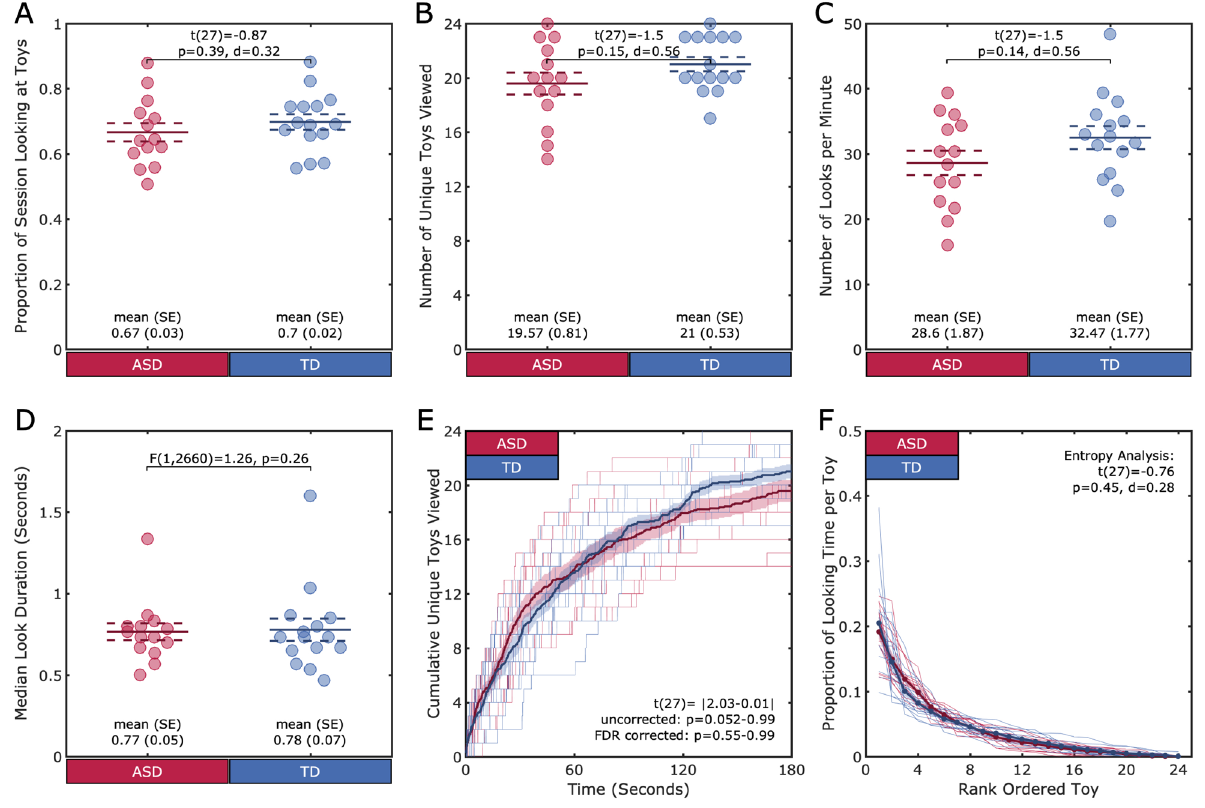
Figure 2. Visual Attention. (A-D) Each individual is represented by a circle. The group mean is represented by the solid line, and the standard error is represented by the dotted lines. (A). Groups did not differ on the proportion of the play session that each child spent looking at toys. (B) Groups did not differ on the number of unique toys (in the set of 24) that each child looked at during play. (C) Groups did not differ on the number of looks to toys that they generated per minute, (D) nor on the median duration of looks to toys. (E-F) Each individual is represented by a thin line. The bold lines represent the group means, and the shaded region represents the standard error. (E) The x-axis is the session time in seconds, and the y-axis is the cumulative unique number of toys viewed, such that each participant’s line increases by 1 each time they view a toy that they have not yet viewed. There were no differences between groups in the rate of looking at previously unviewed toys. (F). The x-axis is the rank ordered toy, such that for each child their most looked at toy is ranked 1 and their least looked at toy is ranked as 24. The y-axis is the proportion of the session spent looking at that toy. There were no differences between groups in the amount of the session spent looking at any of the toys, in rank